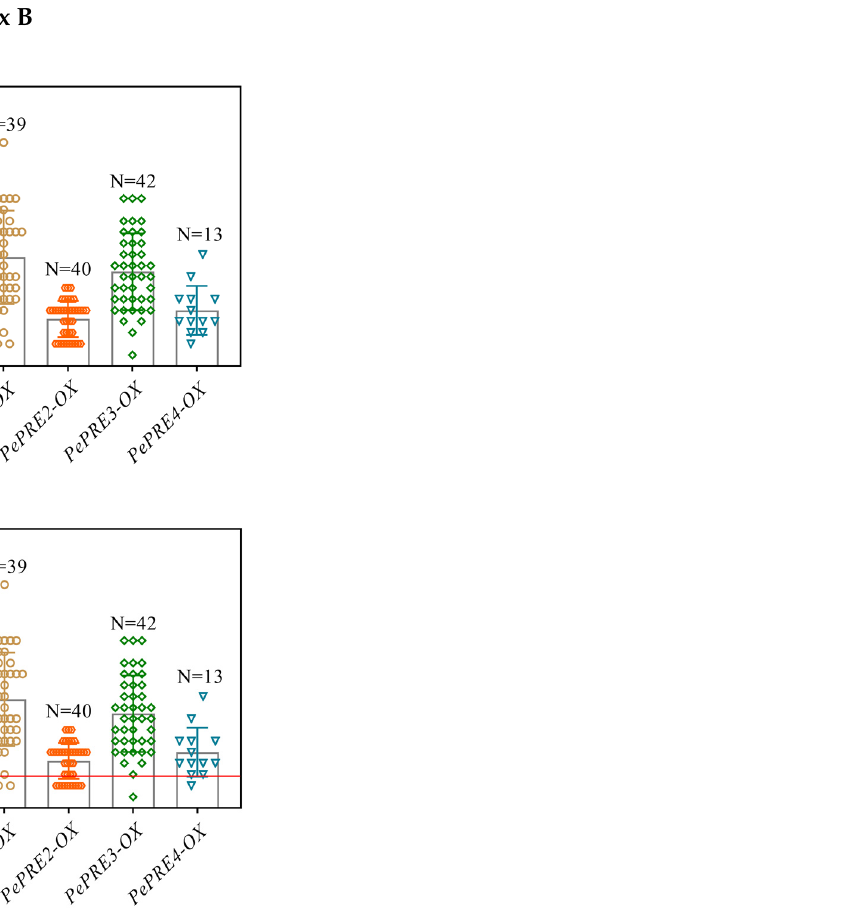
Figure A3. The PePRE1-OX transgenic seedlings were treated with PPZ. The relative hypocotyl length ( a ) and relative root length ( b ) of PePRE1-OX and control plants were treated with mock solution and a gradient concentration of PPZ. Seedlings were grown on medium containing di ff er- ent concentrations of PPZ for 7 days under constant light. The relative hypocotyl/root length was the average of at least 20 seedlings and normalized to the untreated seedlings. Error bars represent standard deviations. References 1.